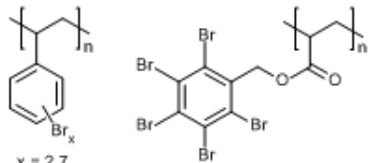
Figure 1. Structures of brominated polystyrene, BrPS, (left) and poly(pentabromobenzyl acrylate), BrPBz (right).